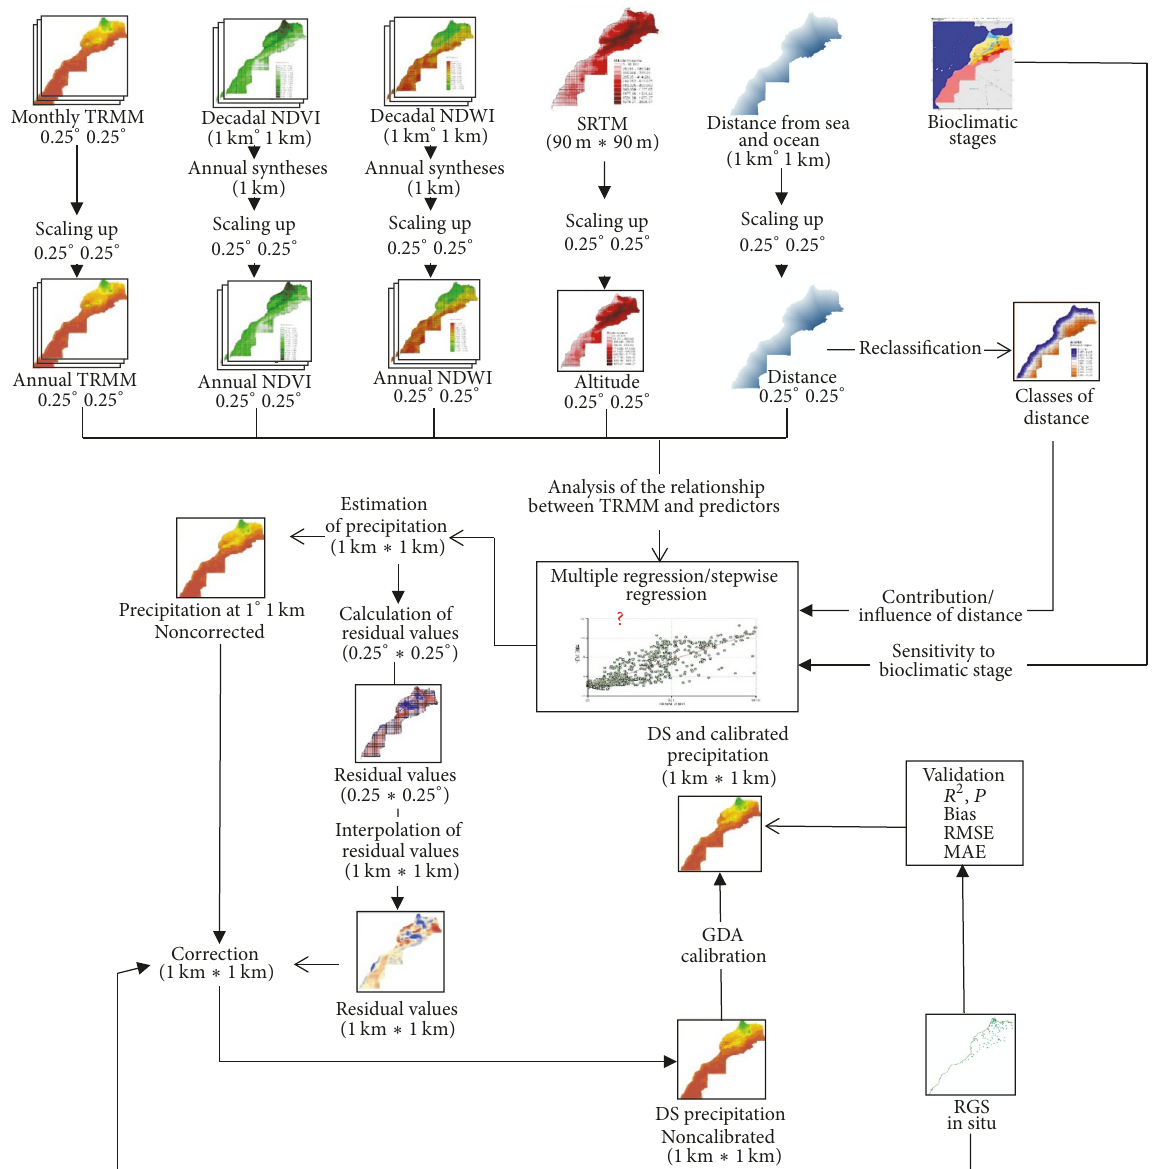
Figure 2: The methodology used in this study. DS: downscaled; GDA: Geographical Difference Analysis.